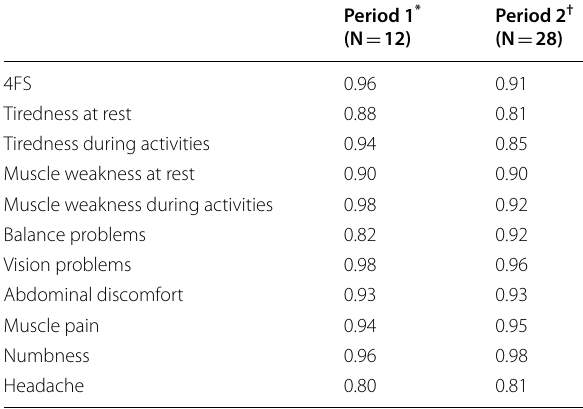
Table 5 Test–retest reliability of the PMMSA